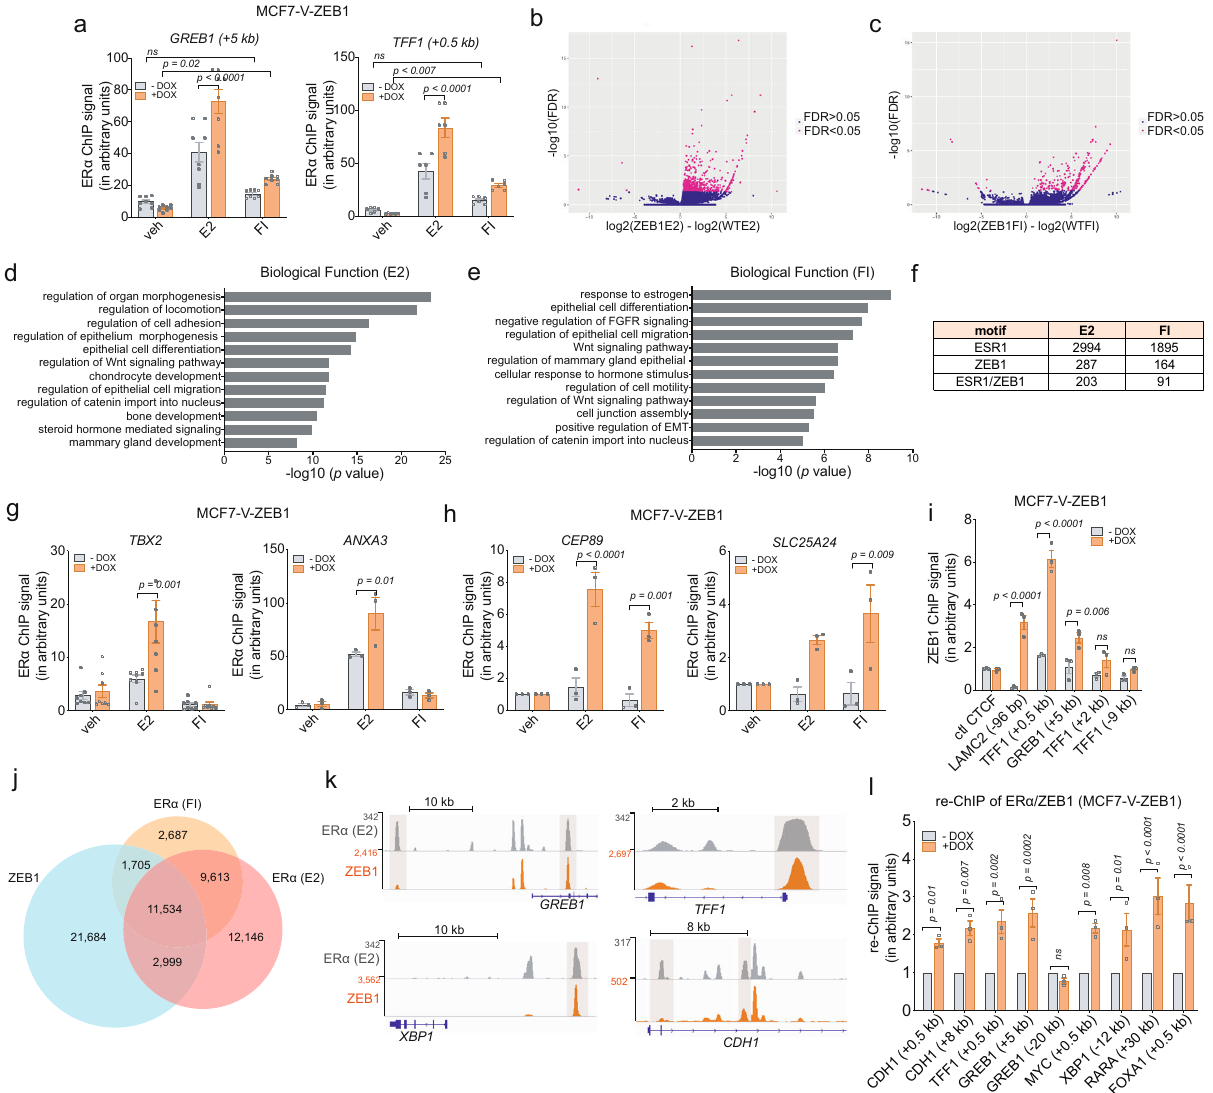
Fig. 2 ZEB1 enhances ER α recruitment at common binding sites. a ChIP-qPCR of ER α on the GREB1 ( + 5 kb) and TFF1 ( + 0.5 kb) binding sites in